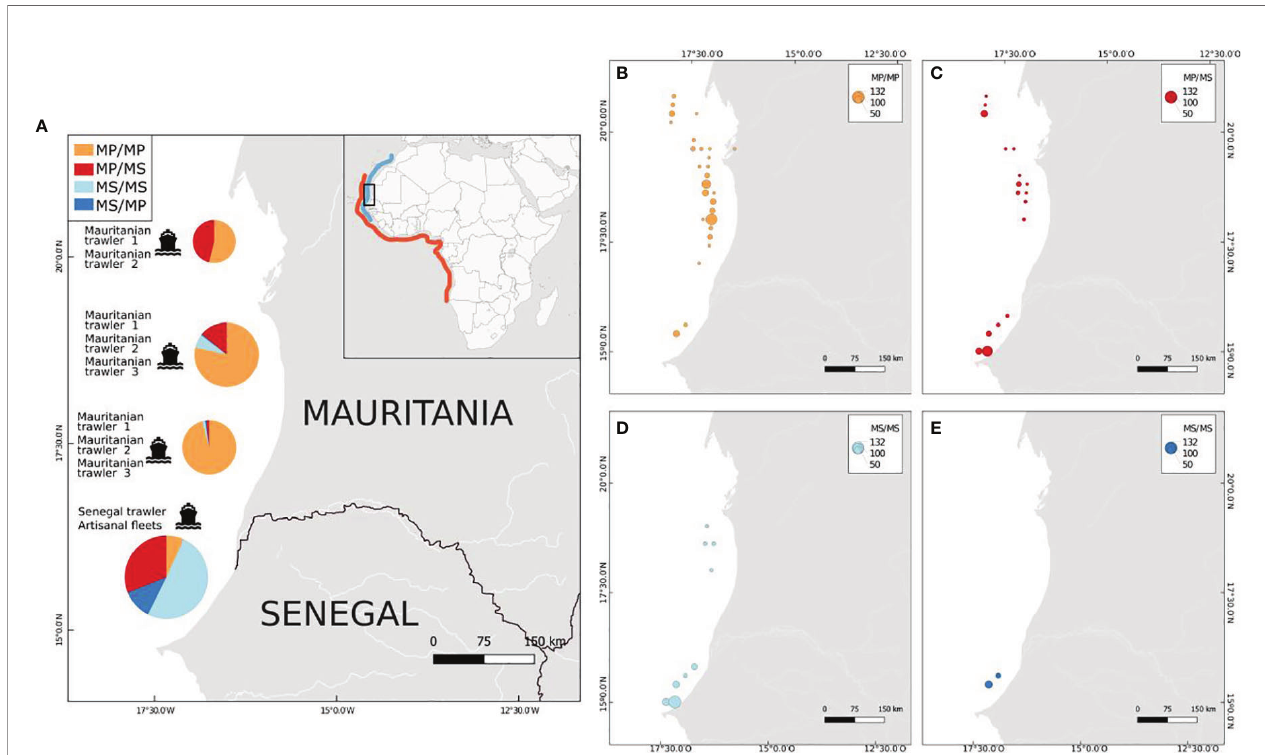
FIGURE 1 | Distribution of catches by labelling and DNA identity along the coasts of Mauritania and Senegal. a-e, Sectors and sampling points are proportional to the number of samples caught in each zone. (A) General proportion of global mislabelling. (B) Distribution of samples labelled as M . polli and DNA-assigned to M. polli (MP/MP). (C) Distribution of samples labelled as M . polli and DNA-assigned to M. senegalensis (MP/MS). (D) Distribution of samples labelled as M . senegalensis and DNA-assigned to M. senegalensis (MS/MS). (E) Distribution of samples labelled as M . senegalensis and DNA-assigned to M. polli